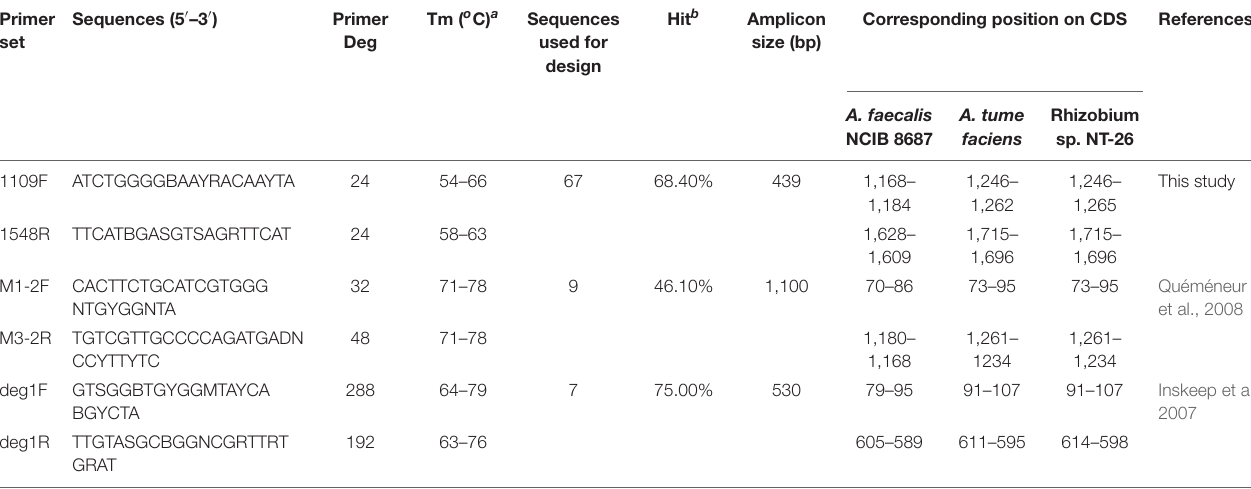
TABLE 1 | Primers for the amplification of the aioA